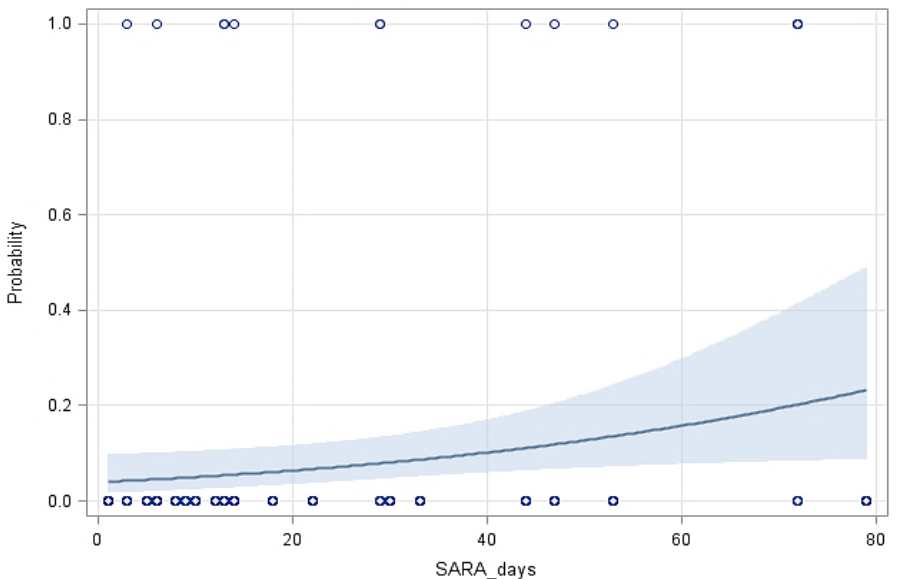
Figure 2. The predicted probability of lameness in cows with the 95% confidence limits (shaded area) based on the duration of SARA (Y = −3.1866 (±0.4834) + 0.0252 (±0.0113) X, p = 0.0257).